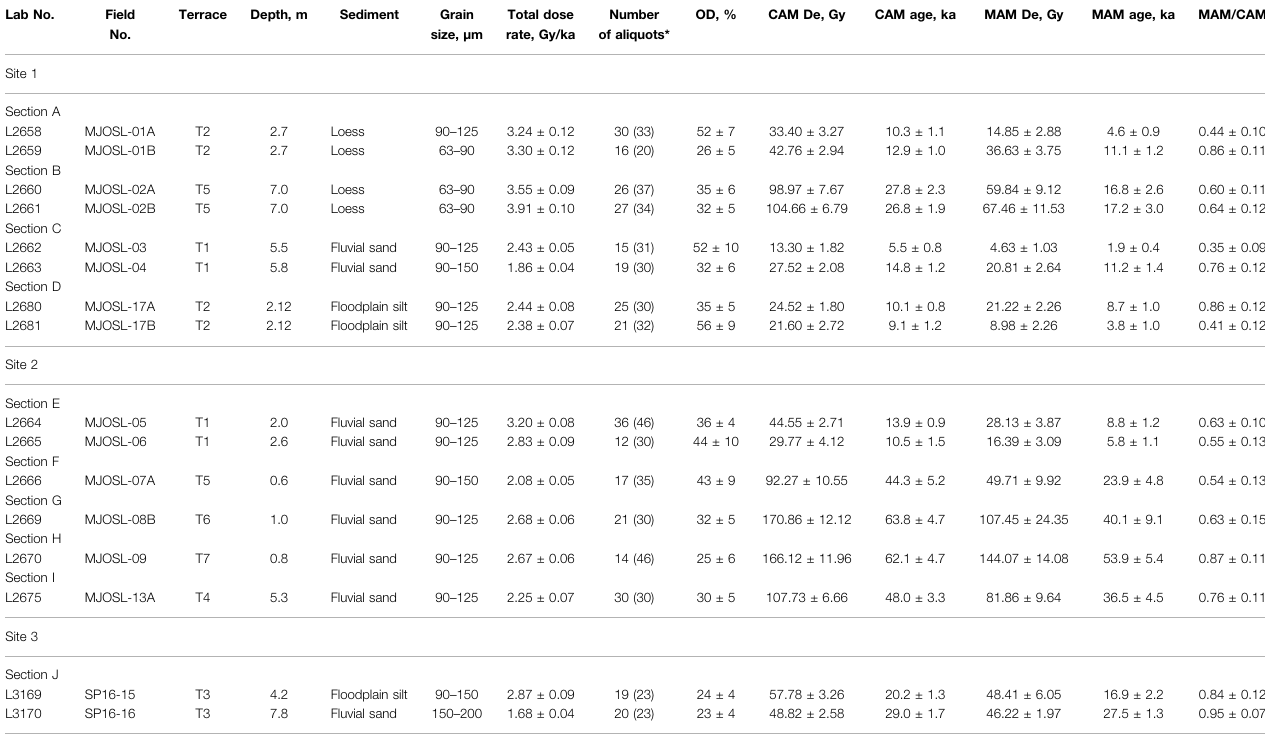
TABLE 2 | OSL dating results of the samples from the Minjiang River. Lab